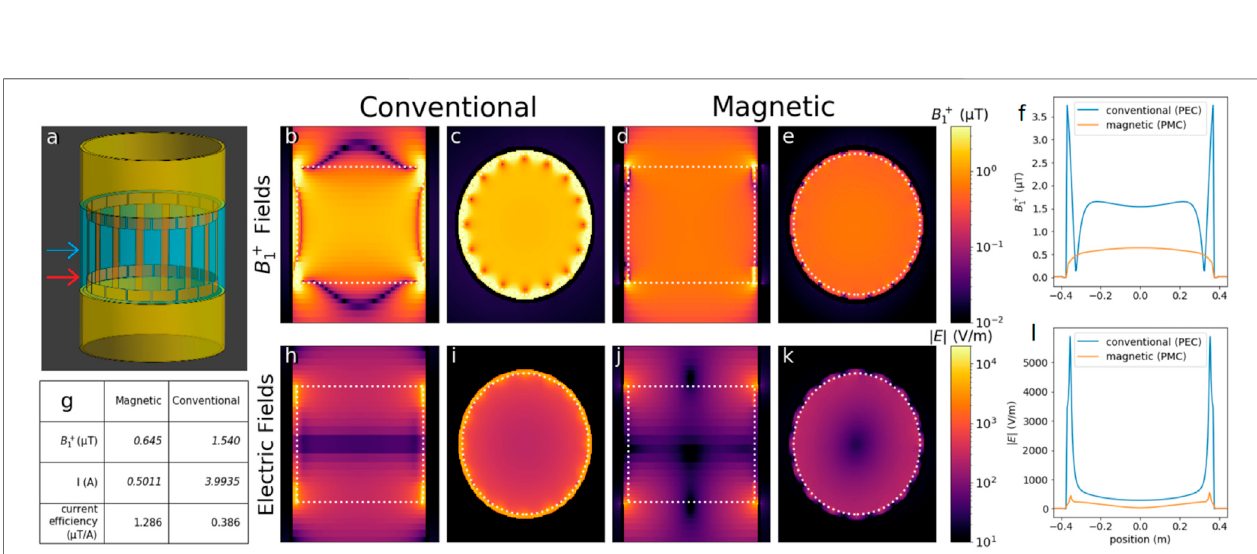
FIGURE 6 | Unloaded birdcage coil fi eld distributions with the conventional (PEC) or magnetic (PMC) shield at 128 MHz. (A) Simulation geometry. The part of the shield simulated as either the conventional or magnetic shield is depicted in blue. The yellow part was PEC for both scenarios. The red arrow indicates the position (z (cid:1) 200 mm)ofthetransverseslices (I,K) andpro fi le(L)oftheelectric fi elds.Thebluearrowindicatestheposition(z (cid:1) 0)ofthetransverseslices (C,E) andpro fi le (F) oftheB 1 fi elds. (B – E) Mid-sagittal and transverse slices of the B 1+ fi elds of the birdcages with conventional (B,C) and magnetic shield (D,E) . (H – K) Mid-sagittal and transverse slices of the electric fi elds of the birdcages with conventional (H,I) and magnetic shield (J,K) . The white dashed line denotes the birdcage outline. (F,L) Transverse pro fi les of B 1 and electric fi elds, respectively, at height indicated by the arrow in (A) . (G) Table summarizing the B 1+ fi eld strength in the center and required current, aswell astheir ratio. Currents arecomputed bynumerically integratingtheAmpère – Maxwell equation. The value listed here isthemaximum ofthe magnitude of the currents in the rungs. All results are normalized to 1 W of accepted power.